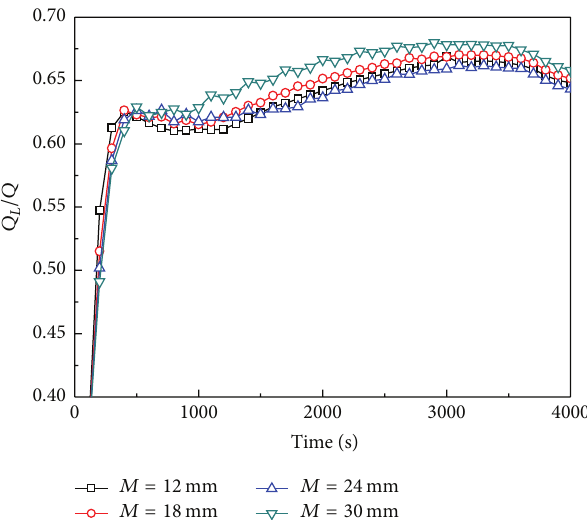
Figure 13: Velocity vector for different tooth ratio.